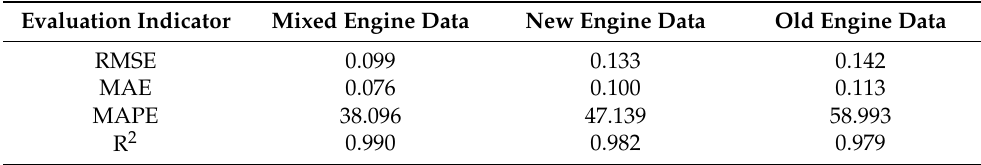
Table 4. Scores for mining mapping relationships under different training methods.